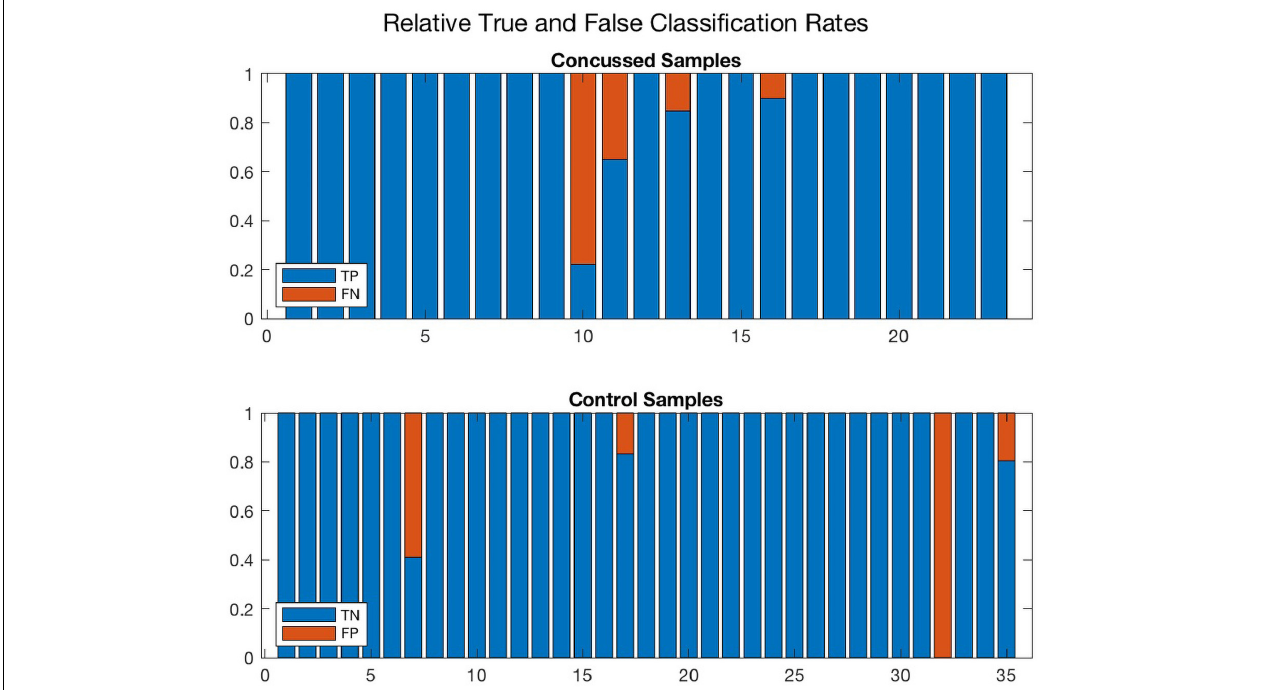
FIGURE 8 | A bar plot representation of the Monte Carlo cross validation test results obtained by means of the ConcNet 3 ensemble of networks (using the six top-scoring channels as input) for the concussed (top) and control (bottom) participants. The blue and red regions in each column illustrate the relative fractions of times that a participant was properly or wrongly classified by the MCCV ensemble. This figure is complementary to Figure 5 which shows the ConcNet 3 median and quartile scores per participant. Two control participants and one concussed participant tended to be systematically misclassified by the networks in the ensemble.